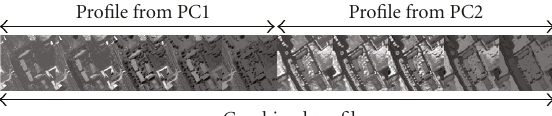
Figure 2: Extended morphological profile of two images. Each of the original profiles has 2 openings and 2 closings. A circular structuring element with radius increment 4 was used ( r = 4,8). The image processed is part of Figure